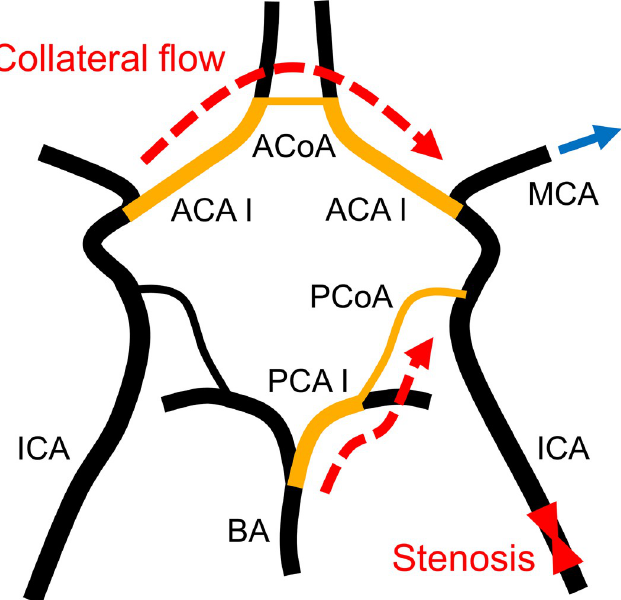
Fig 12. Collateral flow to the middle cerebral artery downstream of the stenosis. The middle cerebral artery receives blood supply from the contralateral and posterior inlets to compensate for the reduced blood flow caused by stenosis. ACA I, anterior cerebral artery I; ACoA, anterior communicating artery; BA, basilar artery; ICA, internal carotid artery; MCA, middle cerebral artery; PCA I, posterior cerebral artery I; PCoA, posterior communicating